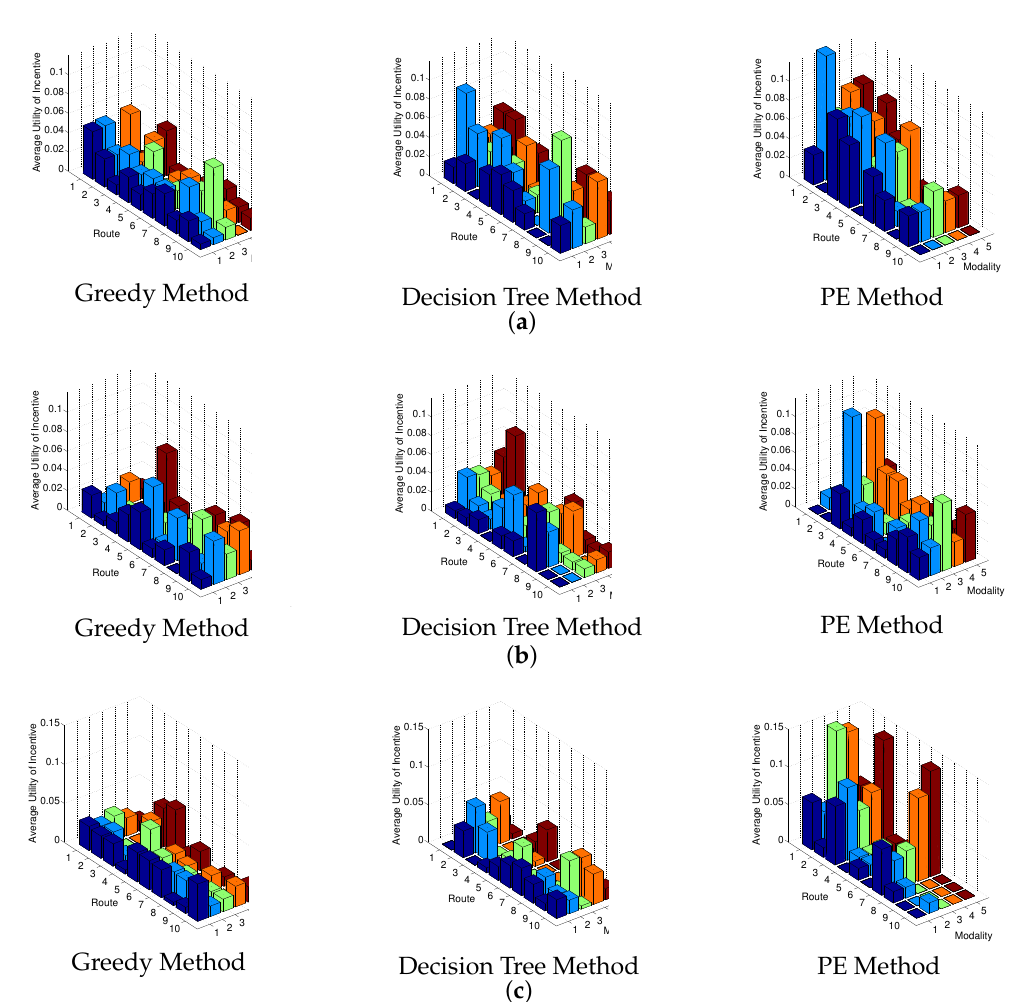
Figure 4. Comparisons of the average utility of incentive using different methods. ( a ) Traveller Scenario 1; ( b ) Traveller Scenario 2; ( c ) Traveller Scenario